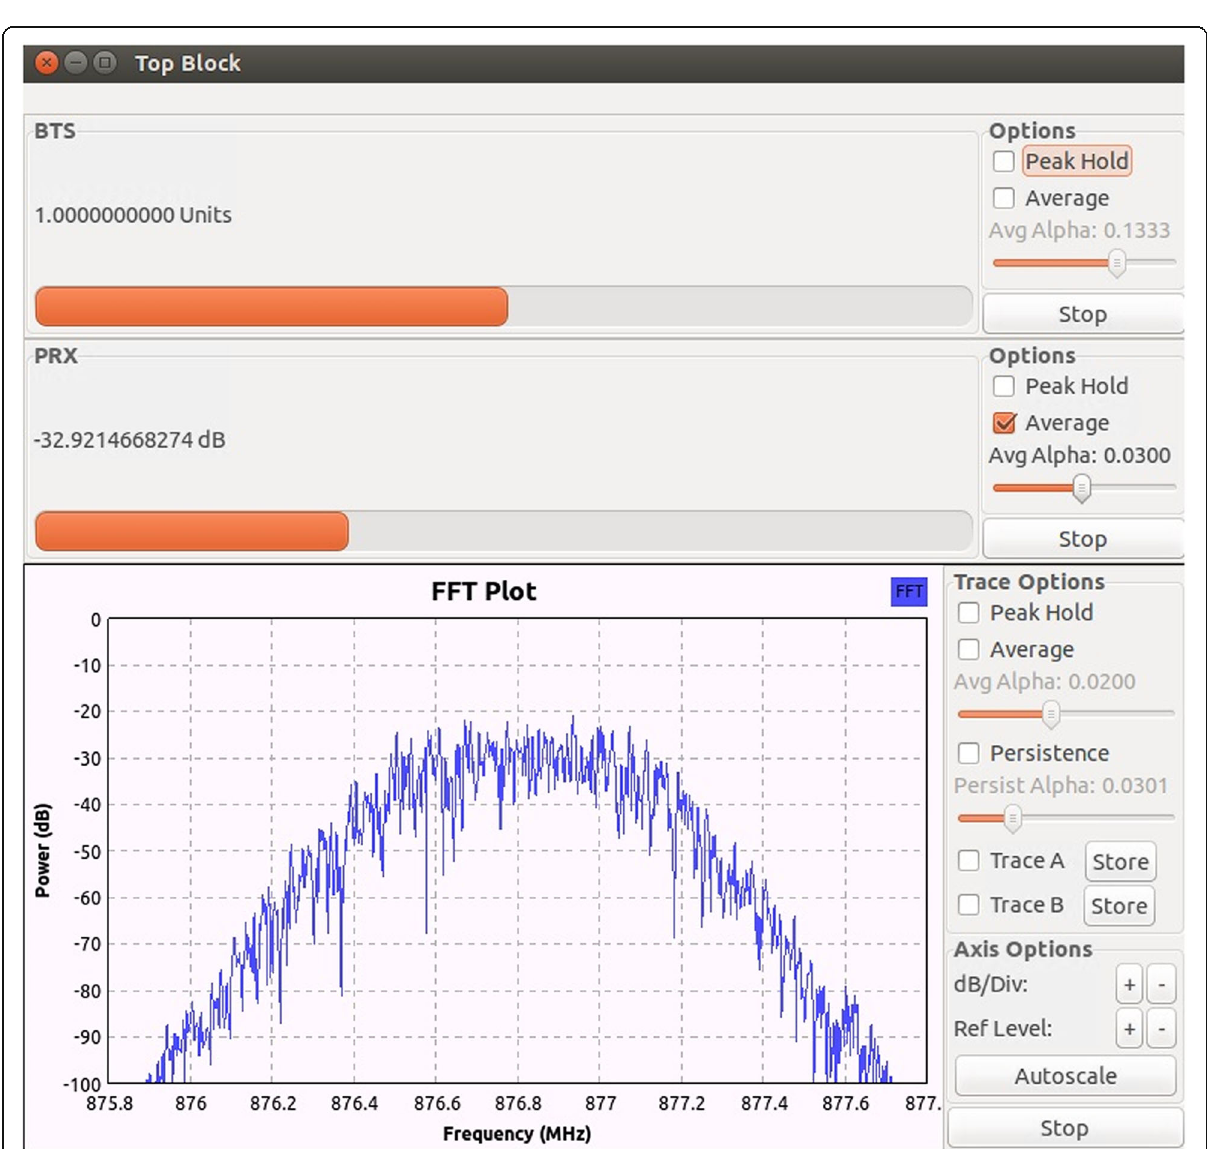
Fig. 12 GNU-radio view of the experiment of downlink DL-876.8